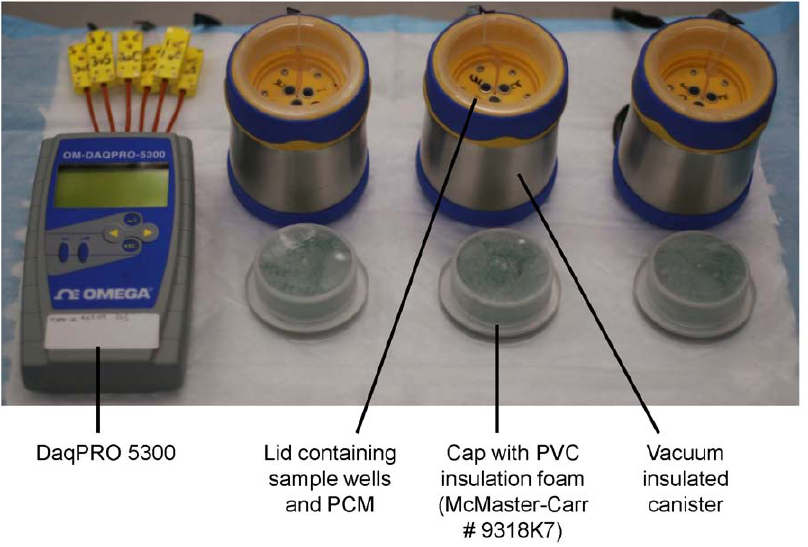
Figure 1. NINA heating devices with DaqPRO 5300 Data recorder.